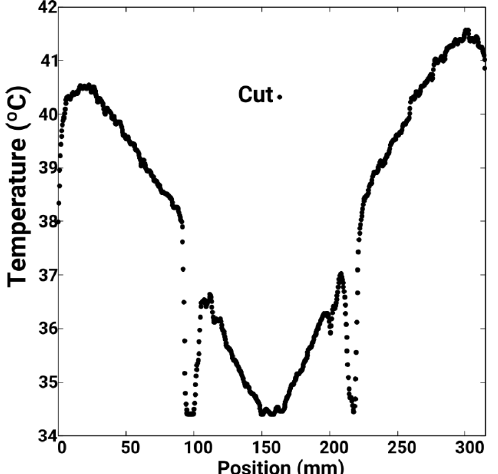
Figure 27. ( a ) Parametric diametric cut – Cut – of the thermogram at instant 1565 s, compared to a CM simulation ( b ) made under the same conditions. Measurement made with the FLIR T425 camera. Sensors 2019 , 19 , x FOR PEER REVIEW